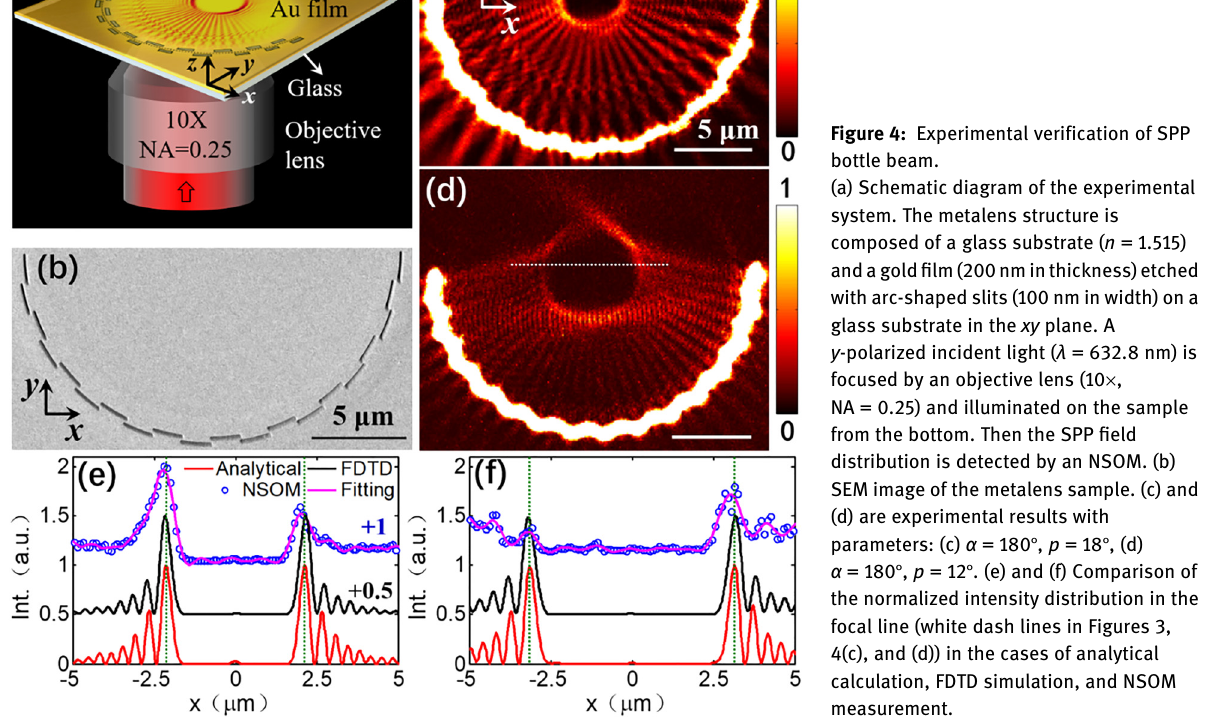
Figure 4: Experimental verification of SPP bottle beam. (a) Schematic diagram of the experimental system. The metalens structure is composed of a glass substrate ( n = 1.515) andagold fi lm(200nminthickness)etched with arc-shaped slits (100 nm in width) on a glass substrate in the xy plane. A